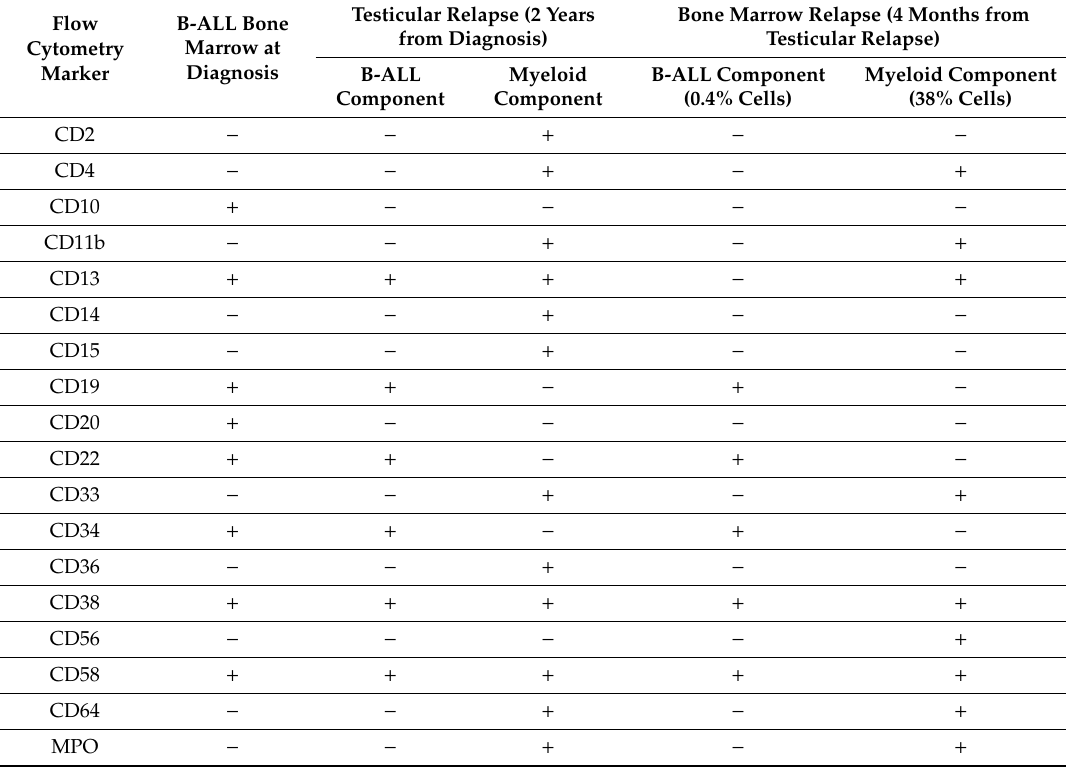
Table 1. Immunophenotypic characteristics of the patient’s initial diagnostic bone marrow, testicular relapse, and bone marrow